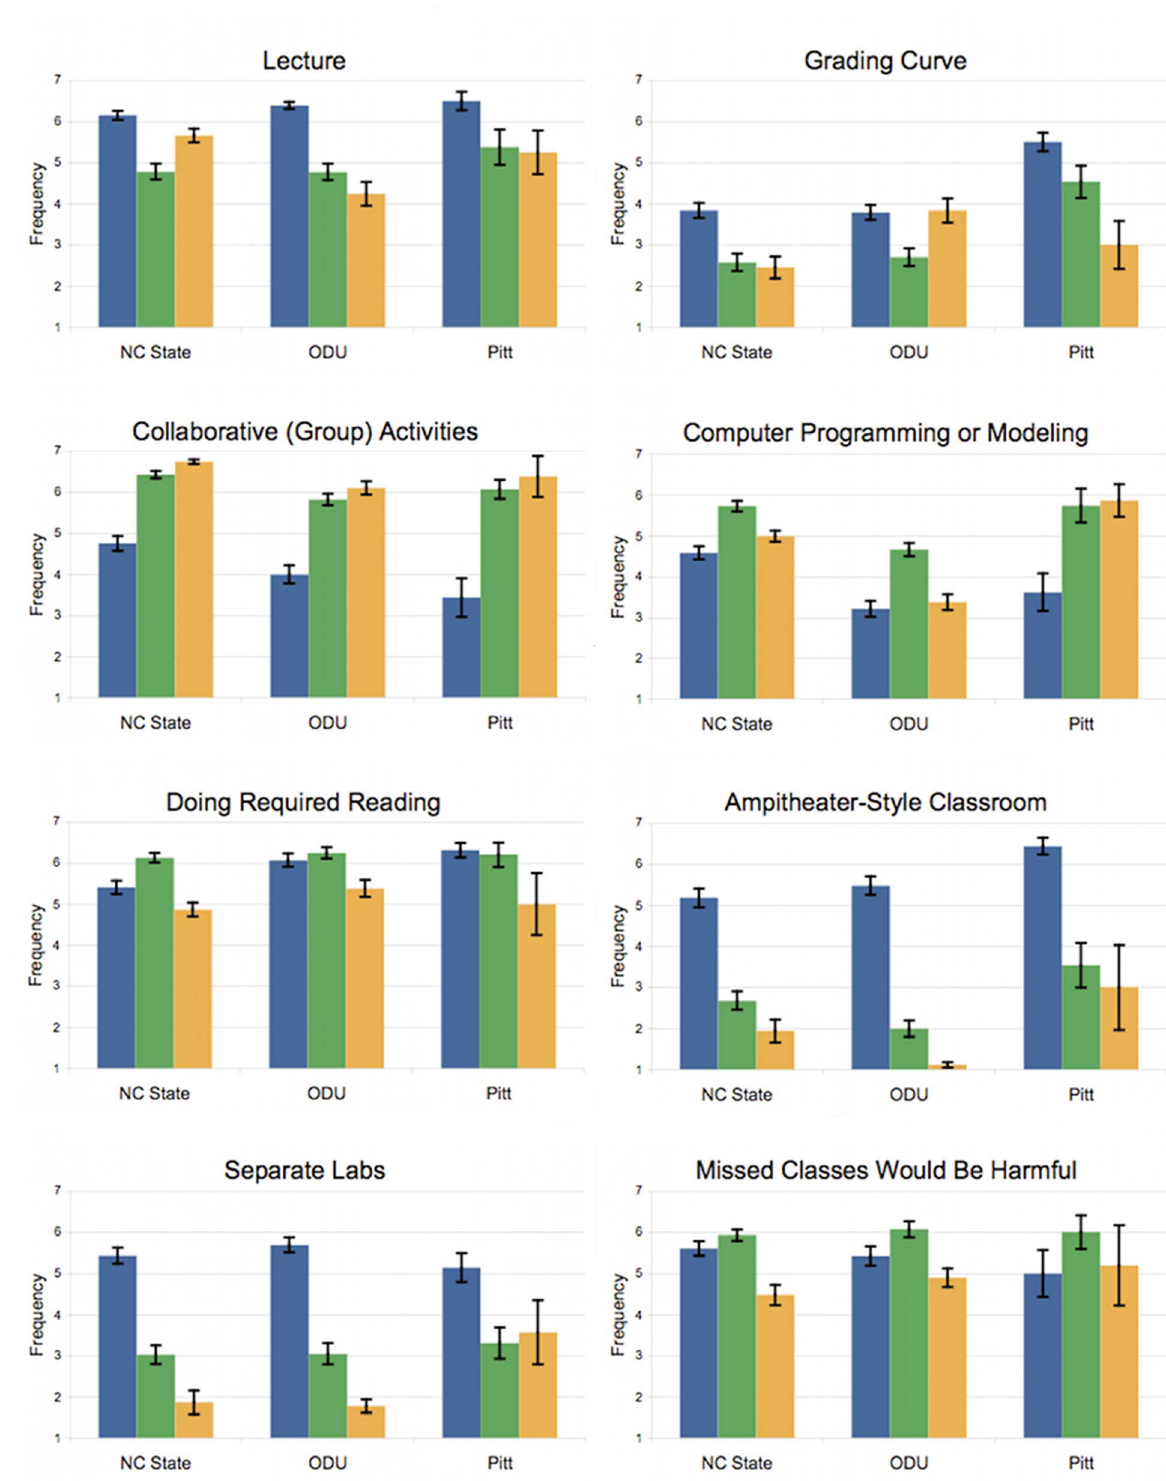
FIG. 1. (cid:1) Color (cid:2) The extent to which students at each school initially expected (cid:1) blue, first column (cid:2) , expected after orientation (cid:1) green, second column (cid:2) , and experienced (cid:1) orange, third column (cid:2) items 1–8 on the